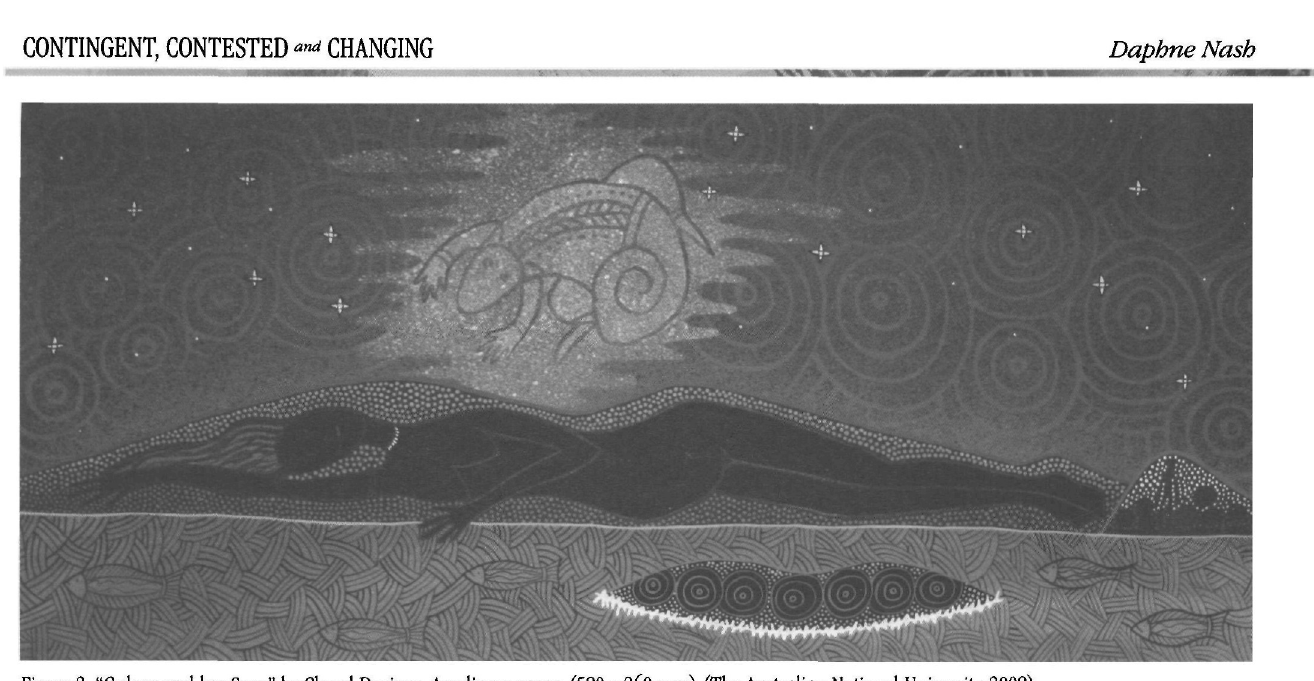
Figure 2. "Gulaga and her Sons" by Cheryl Davison. Acrylic on paper. (580 x 260 mm) (The Australian National University,